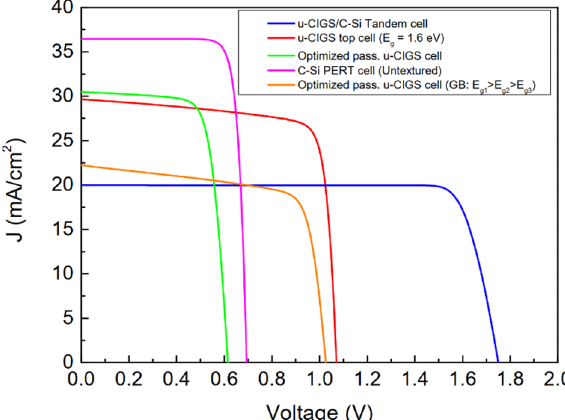
Figure 19. Schematic of optimized u-CIGS/C-Si PERT tandem solar cell.